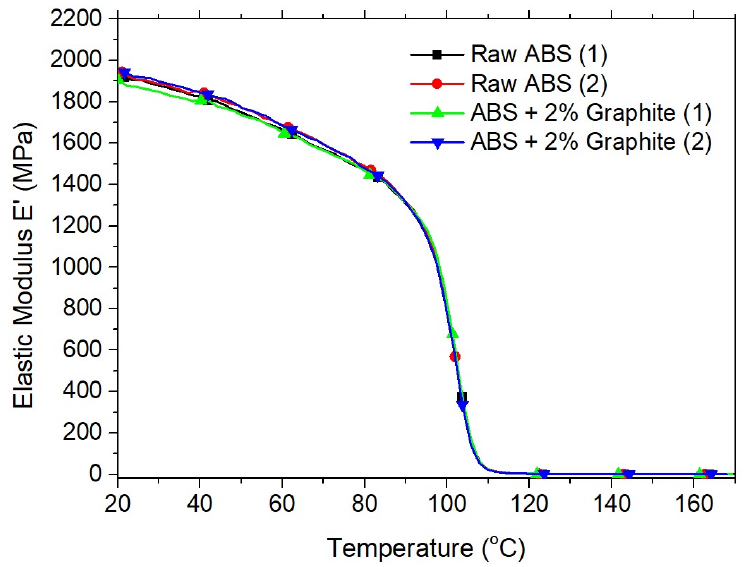
Figure 6. DMA results of ABS based Filaments.